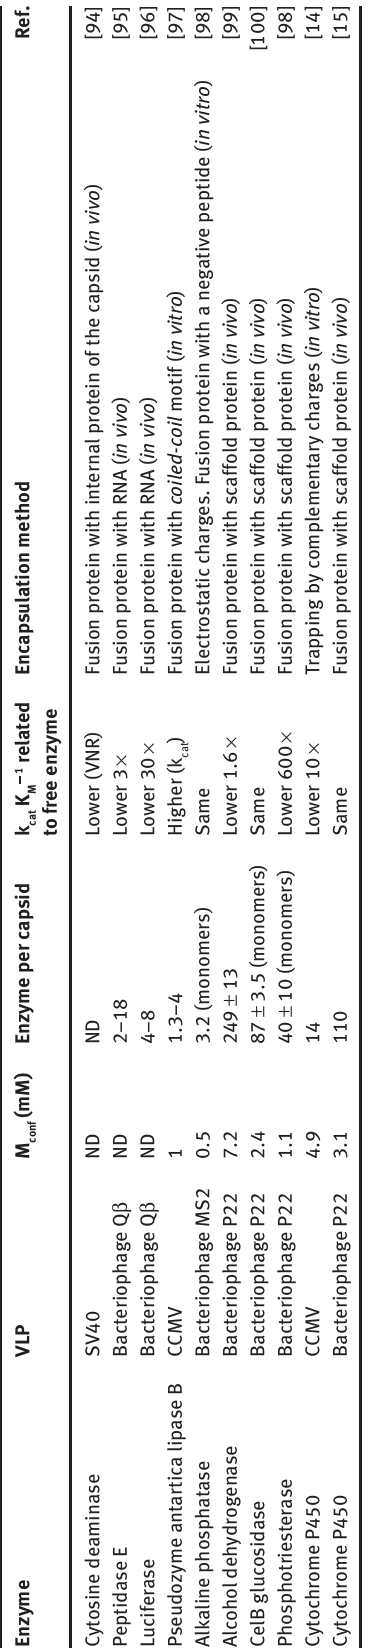
Figure 3: Transmission electronic microscopy of P22 capsids con- taining cytochrome P450 [112].